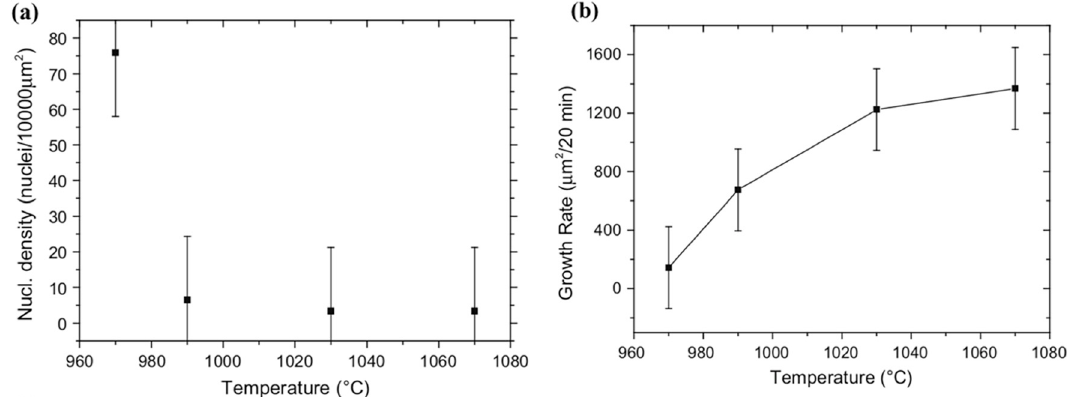
Figure 7. Analysis plots showing ( a ) nucleation density versus growth temperature, ( b ) nucleus growth rate versus growth temperature (reprinted with permission from [78]).